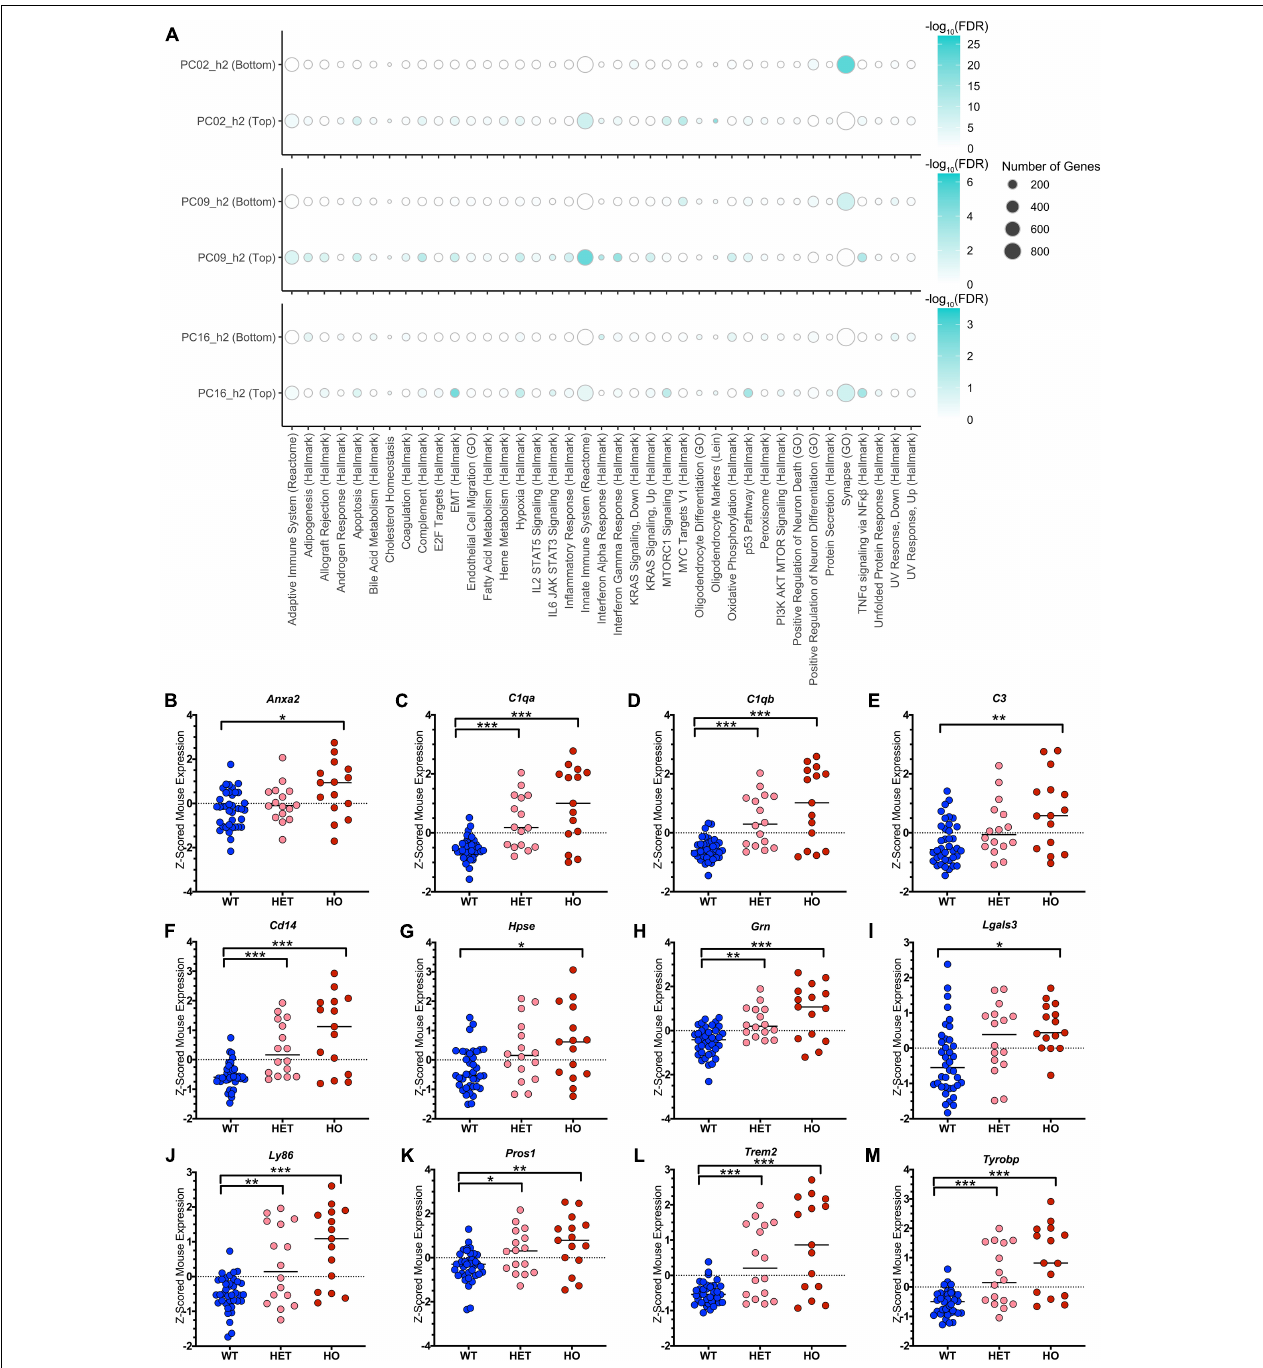
FIGURE 6 | TransComp-R identifies complement and TAM receptor agonist signatures from LOAD human patient and TASTPM mouse samples. (A) Dot plot heatmap showing pathways that are statistically enriched at the top and bottom 20 percent of each principal component’s loadings relative to all genes present in the PC. The full list of original pathways evaluated in Supplementary Table 1 . A pathway is included in the figure if it was enriched at an FDR < 0 · 05 in any of the six groups (three PCs, top and bottom) evaluated. Dot size for pathway enrichment indicates the number of genes from the original gene set list that are also present in the PCA model and thus available for potential enrichment. Color intensity represents the -log 10 (FDR) value and is normalized to the maximum -log 10 (FDR) value on a PC-by-PC basis. (B–M) The Innate Immune System (Reactome) pathway is enriched at the top of PC9_h2. Genes that contributed to the enrichment of the pathway were evaluated in terms of z-scored mouse gene expression. Genes that had a significant t -test comparison between either the wild type (WT) and heterozygous TASTPM (HET) or WT and homozygous TASTPM (HO) samples and were associated with a secreted protein in the UniProt database are shown. (* < 0.05, ** < 0.01, *** < 0.001, Benjamini-Hochberg corrected for multiple hypothesis testing; the median of each group is indicated in addition to the values for each sample).